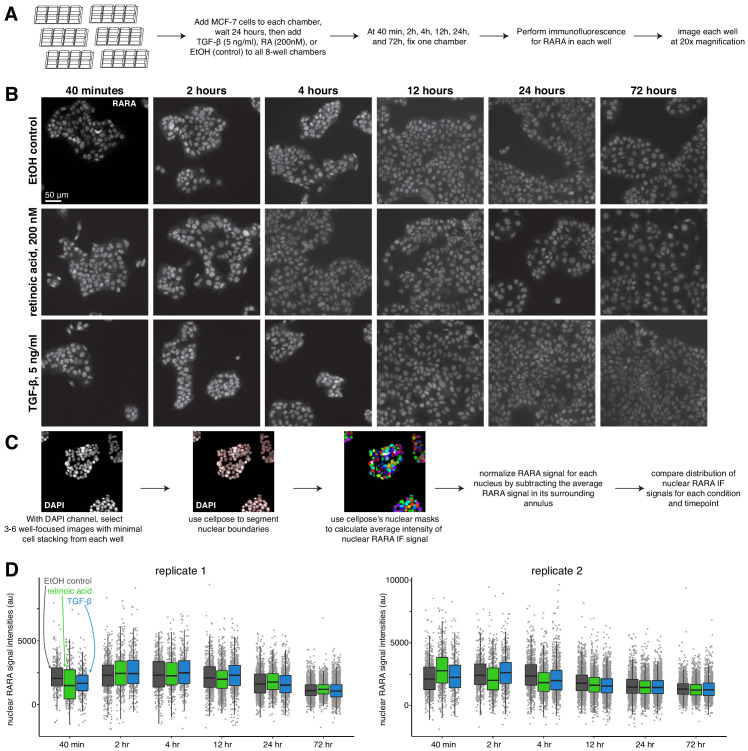
Nuclear retinoic acid receptor alpha levels are stable across treatment conditions.(A) Schematic describing immunofluorescence experiment design. (B) Example images of RARA immunofluorescence for each condition (medium dose of retinoic acid, TGF-β, or control) at each time point. (C) Computational analysis workflow schematic, which describes how we use the cellpose segmentation algorithm in the DAPI channel to identify nuclear boundaries for measuring average nuclear signal intensity in the RARA immunofluorescence channel. (D) Summary statistics of normalized RARA nuclear intensity, where each point represents the average immunofluorescence signal intensity of one nucleus.